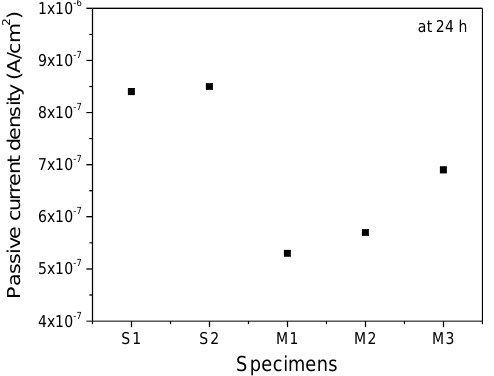
Figure 8. Passive current density after 24 h.